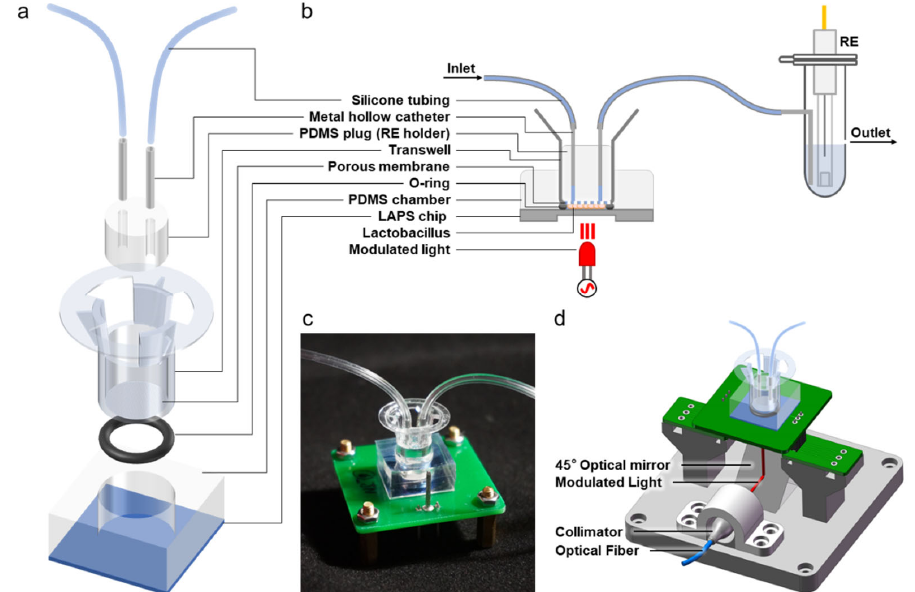
Figure 3. Schematic of microphysiometer sensor unit with the Transwell insert. ( a ) Schematic of the detection chamber fabricated by the Transwell insert with a microporous membrane. ( b ) Schematic of the microphysiometer sensor unit with a microfluidic structure. ( c ) Photography of the device. ( d ) Schematic of the 3D ‐ printed resin scaffold used to fix the optical path and the sensor unit.